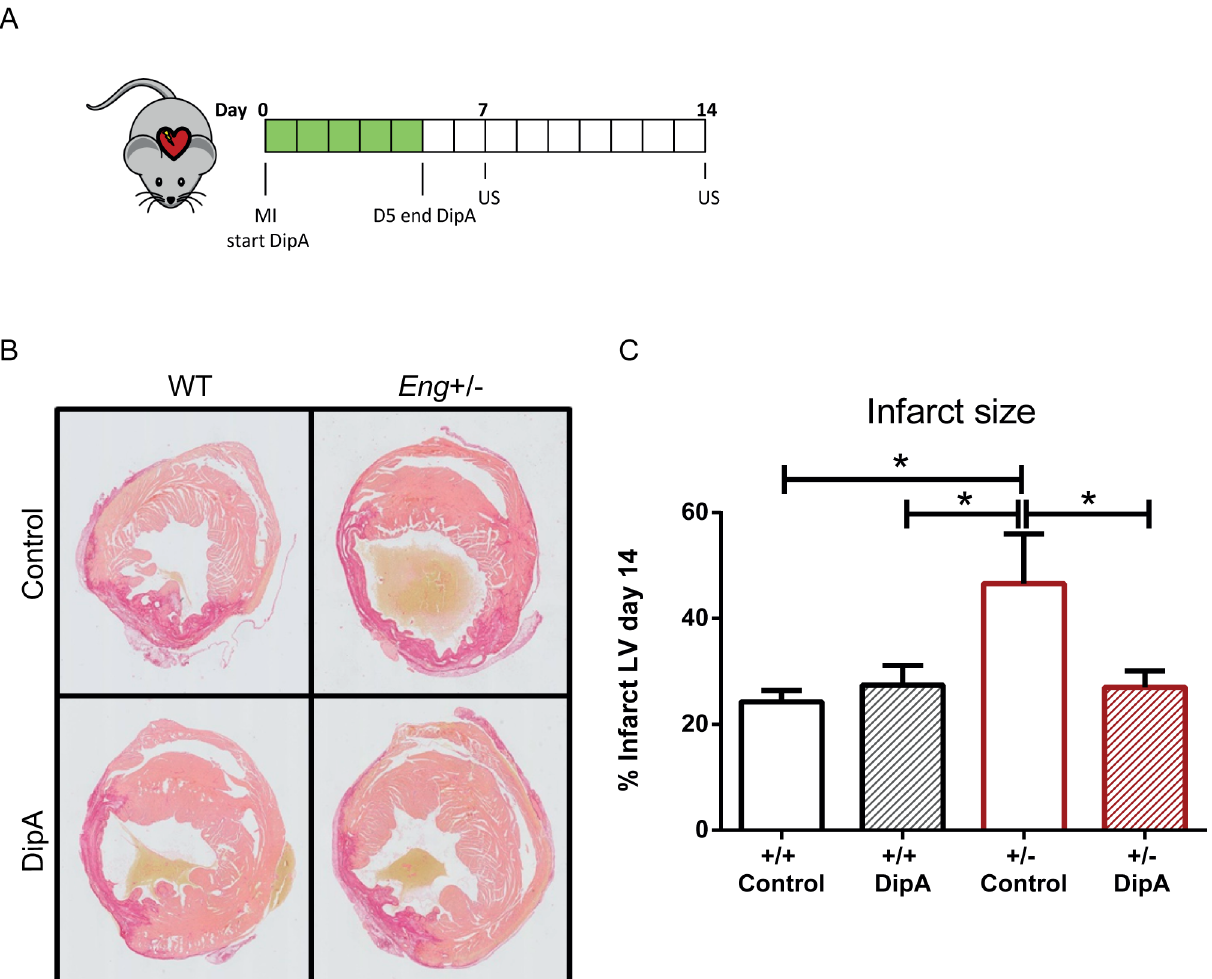
Fig 3. DPP4inhibitor treatment reducesinfarct size. (A) Experimentalprotocoland treatment overview. At day 0, MI is inducedand DPP4 inhibition is started (shownin green)till day 5 post-MI by intraperitoneal(i.p.) injectionof DipA(treatment group)or distilledwater (controlgroup). Cardiac echography was performed at day 7 and 14 post-MI. (B) Histological analysisof the infarct size by Picrosiriusred stainingfor collagen (n = 5–9). Transverse sectionsof left ventricle, photostaken at 1.0x magnification.Infarct area = dark pink, healthymyocardium= light pink, bloodcells = yellow. (C) Quantification of Picrosiriusred stainingin left ventricle(LV). Mice weresubjectedto MI and treated with eitherdistilled water or DipA from day 0 till day 5 by daily i.p. injection(n = 5–9). Control = MQ treated, DipA= DiprotinA treated group.Data shownare mean ± SEM, * P <